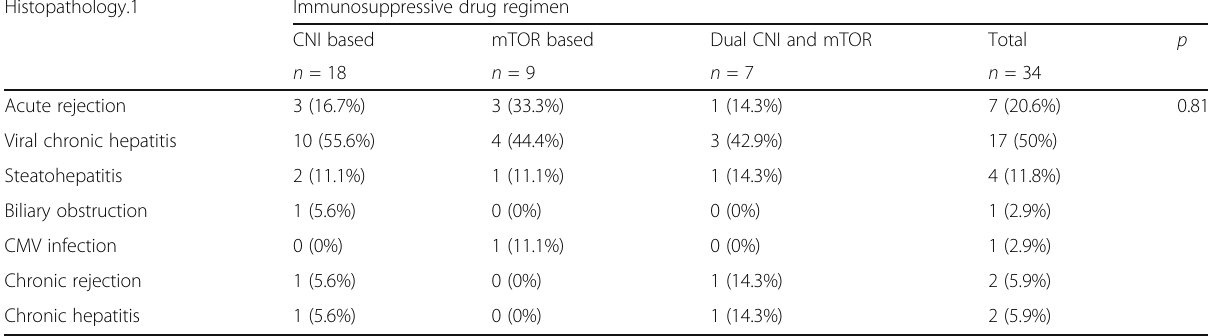
Table 3 Effect of the immunosuppressive drug regimen on the liver histopathological diagnosis